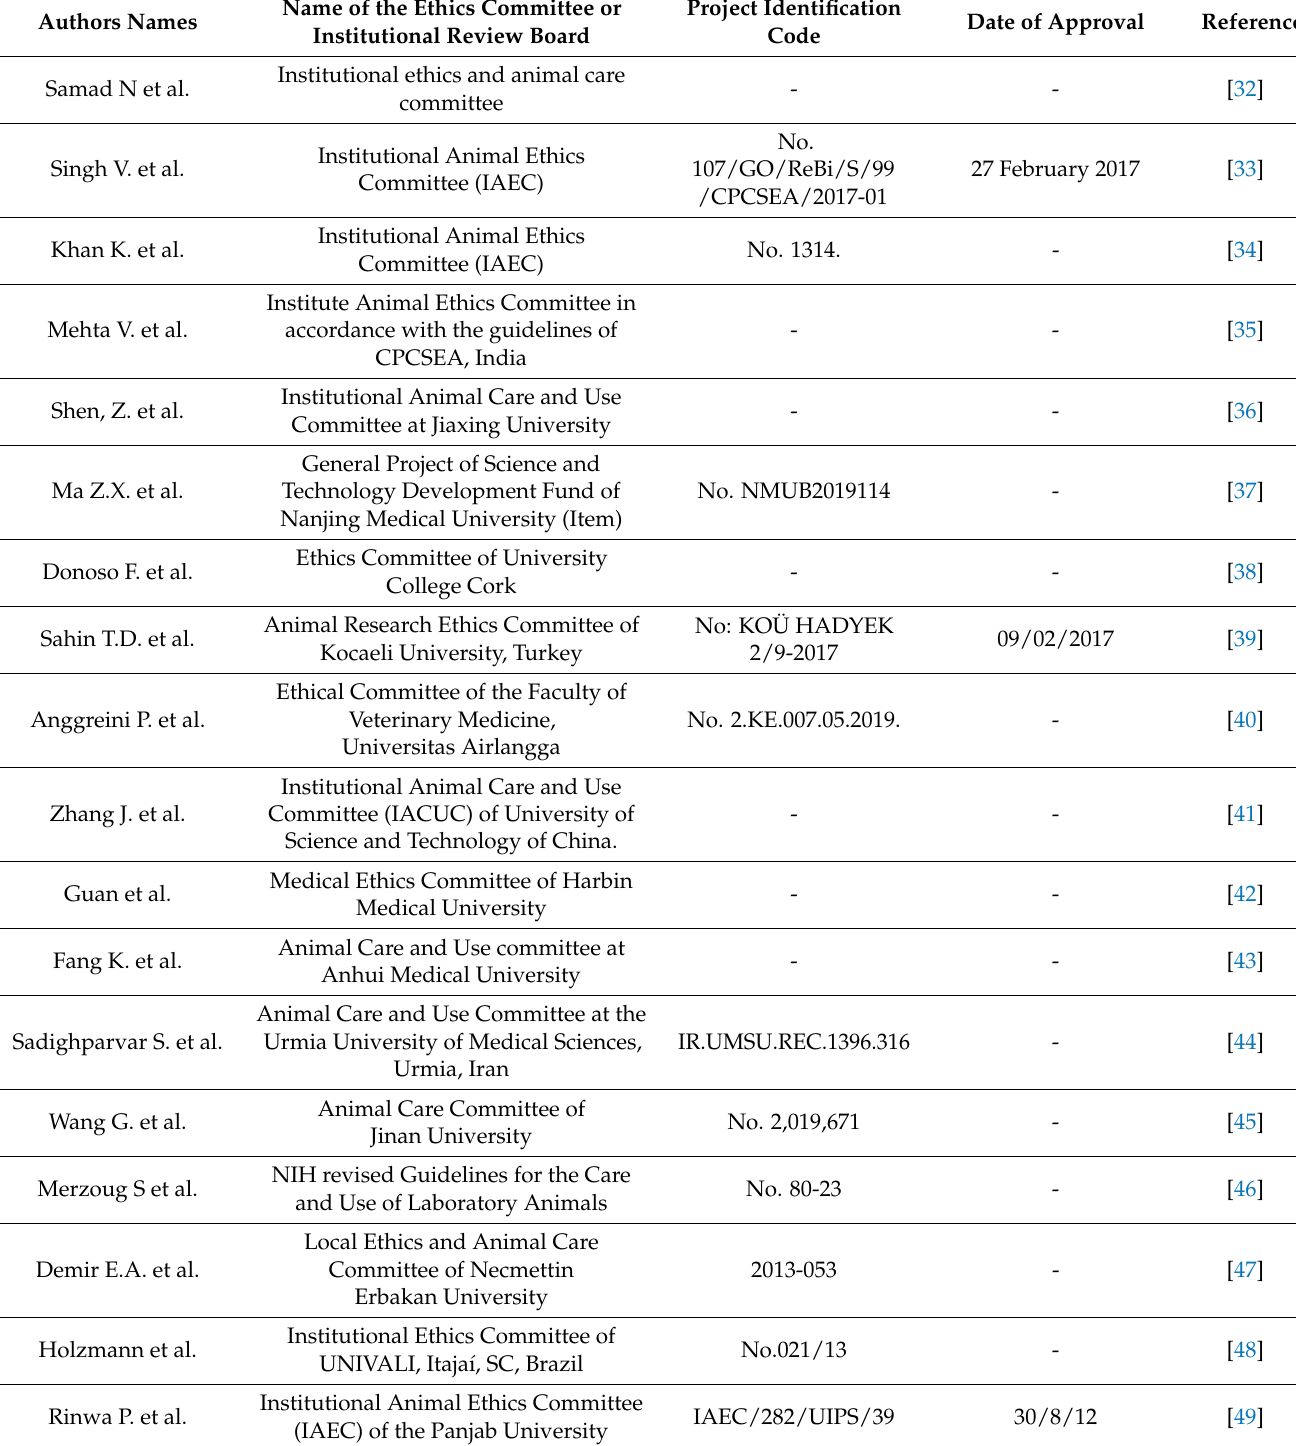
Table 1. Details of the approval by the appropriately constituted research ethics committee (project identification code, date of approval, and name of the ethics committee or institutional review committee) of studies performed on the animal models mentioned in the